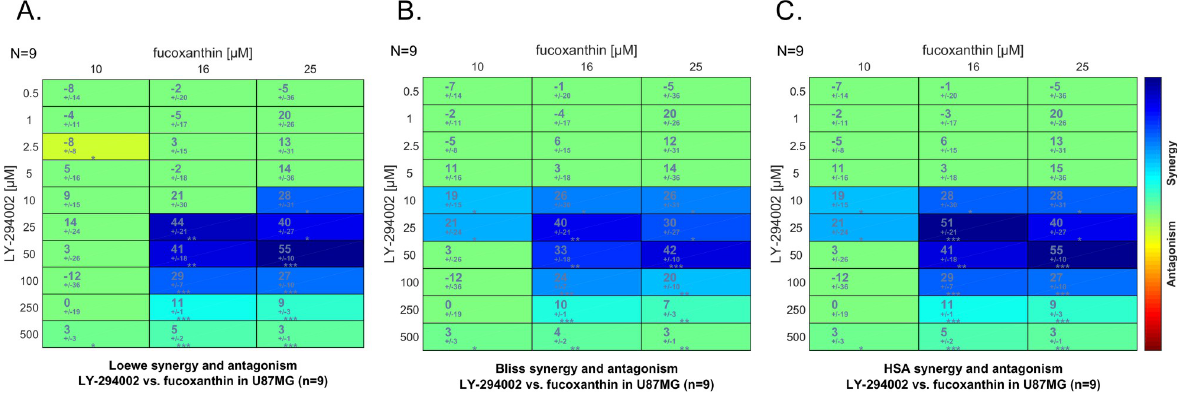
Fig 7. The synergy model used does not affect the synergy observed between fucoxanthin and LY-294002. A) Loewe synergy model, additive model, B) Bliss synergy model, product-based model, C) Highest Single Agent model–only one agent’s effect is considered. In all figures, the color indicates the degree of synergism and the values indicate synergy scores calculated as described in [43]. The higher the synergy is, the darker blue the background, and the higher the synergy score. Asterisks indicate significance of the synergy scores obtained following a one sample t-test ( � p < 0.05; �� p < 0.001, ��� p < 0.0001; the number of replicates (N) is shown on the left top corner of the matrix display).